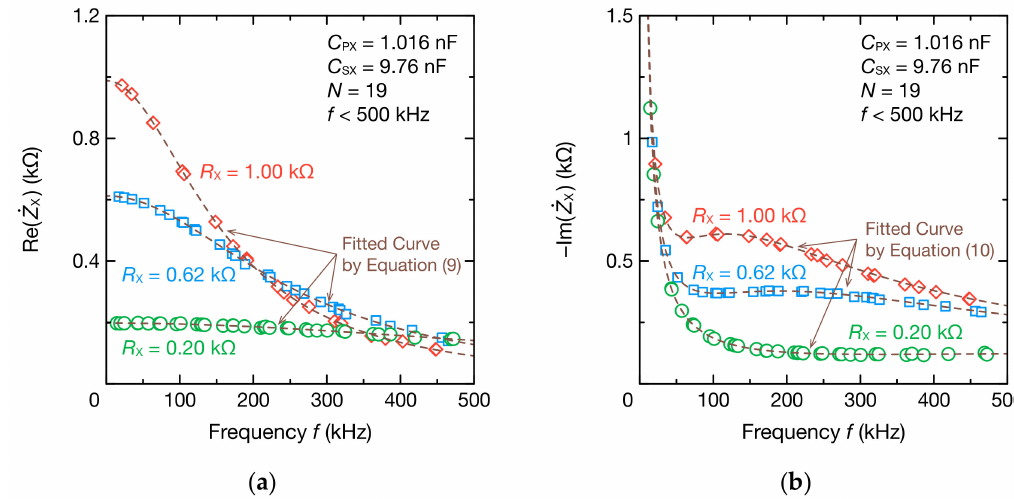
(cid:16) . (cid:17) Z X and ( b ) imaginary part Im